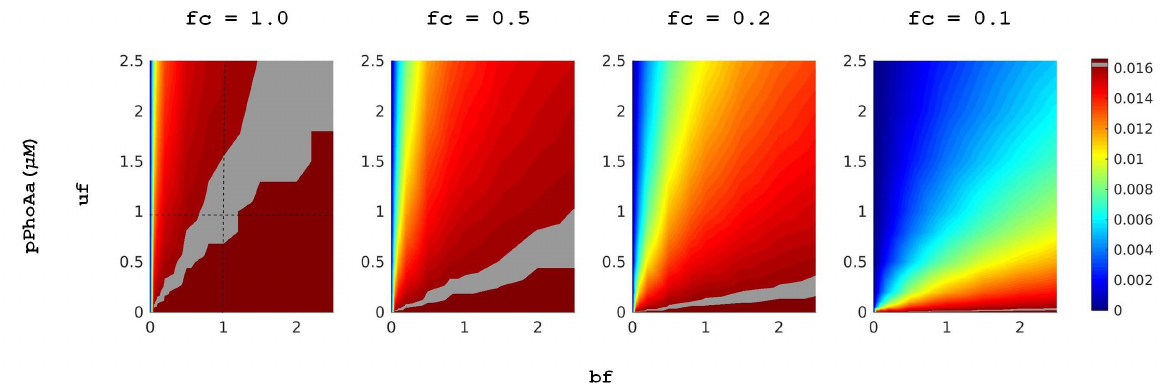
Figure 4. Heatmaps for the activity of various promoter designs as in [11]. The heatmaps are ordered according to the external P i concentration given by the fold changes fc applied to the PhoR autphosphorylation reactions. The left most column with 1.0 as the fc value is the starvation condition with 0 µ M external P i . Each heatmap scans 100 simulations by applying 10 different fold change values to the promoter binding rates, given with bf in r16 and r18 , as well as 10 different fold change values to the promoter unbinding rates, given with uf in r17 and r18 in the full model in the Supplementary Materials. The heatmaps display the resulting steady-state levels of the active promoter pPhoAa in deterministic ordinary differential equation simulations. The intersection of the dashed lines in the left column delivers the experimentally observed regime reported in [11]. The levels of this regime that display the starvation response are highlighted in all the